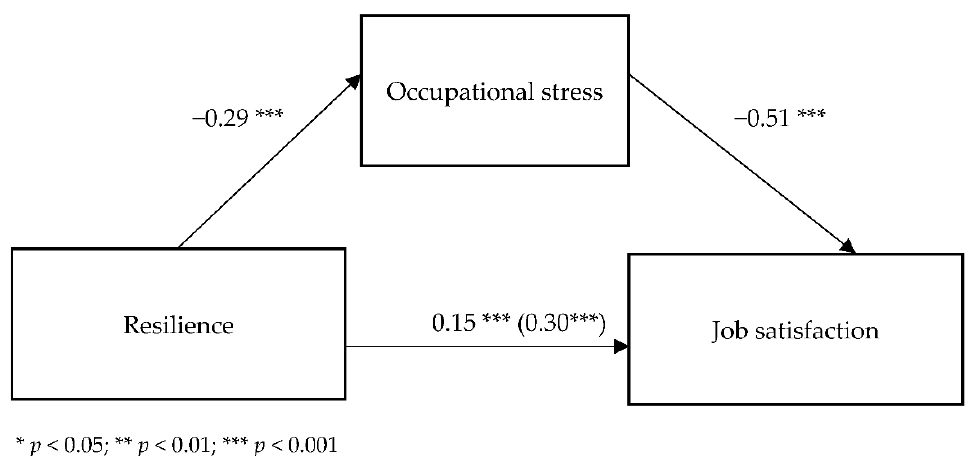
Figure 2. Standardized regression coefficients for the mediational model of occupational stress be- tween resilience and job satisfaction.